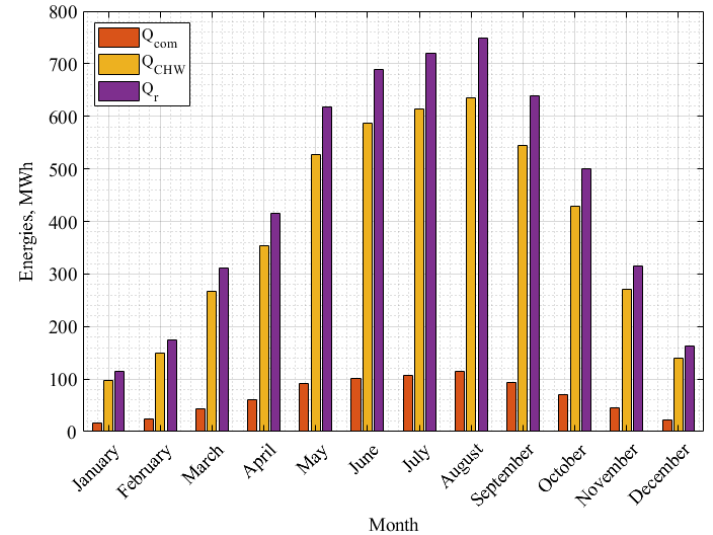
Figure 15. Monthly distribution of energies of the VCC